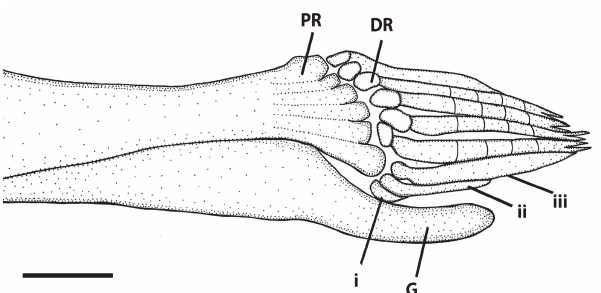
Fig. 2. Gonopodium and osteology of the anal fin of an adult male of Gelanoglanis pan , holotype, 24.7 mm SL, MZUSP 114669, showing fusion of the proximal radials. DR = distal radials, G = gonopodium, PR = fused proximal radials, i-iii= anterior unbranched and unsegmented anal-fin rays. Scale bar = 1 mm.